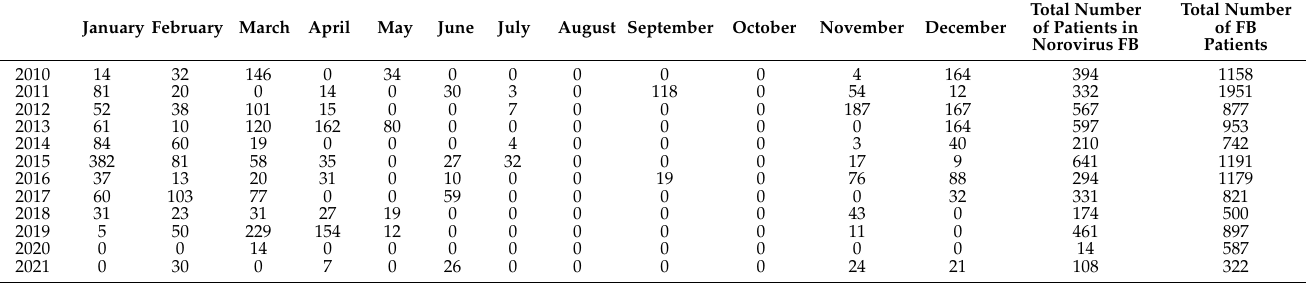
Figure A1. Ratio of human mobility flow in 2020 − 2021 relative to the same week in 2019 in Osaka and Iwate (%). Table A1. Monthly number of patients from norovirus-positive foodborne (FB) outbreaks in Osaka since